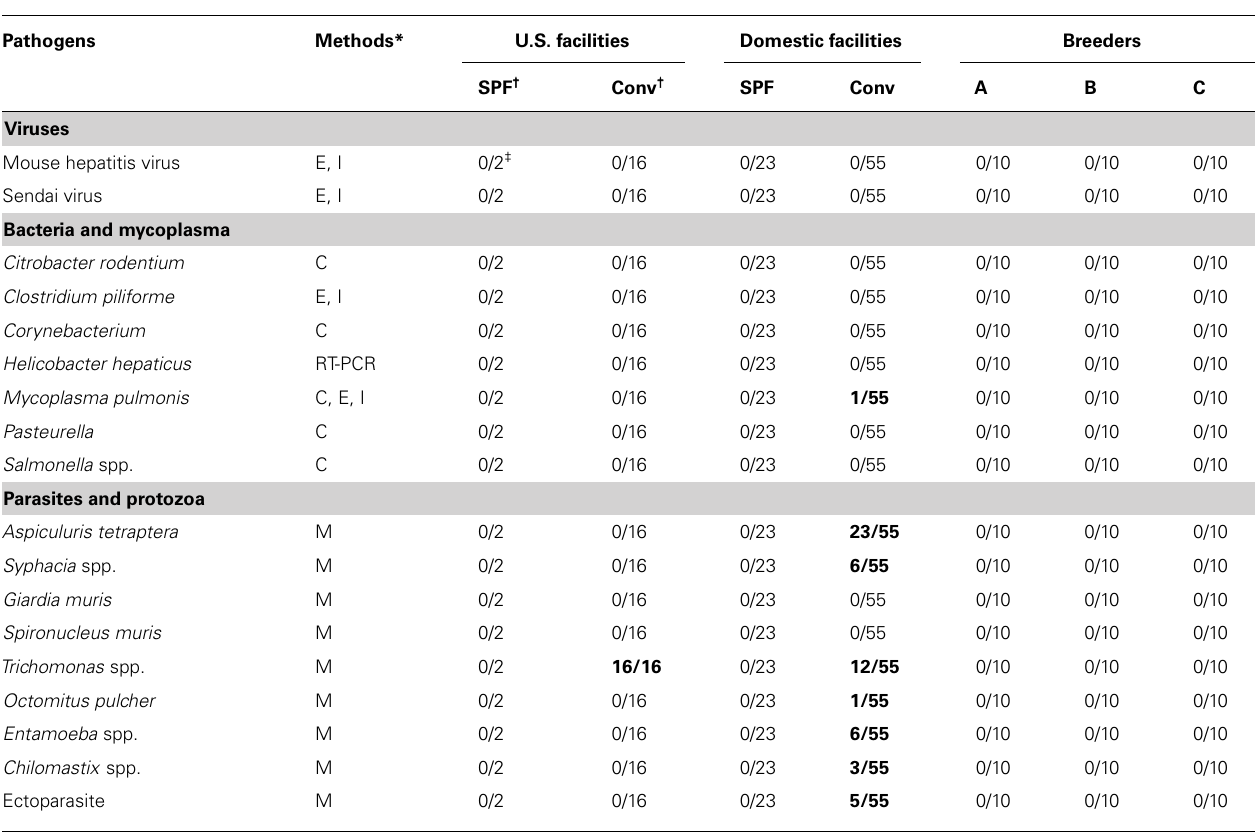
Table 1 | Microbiological status in tested